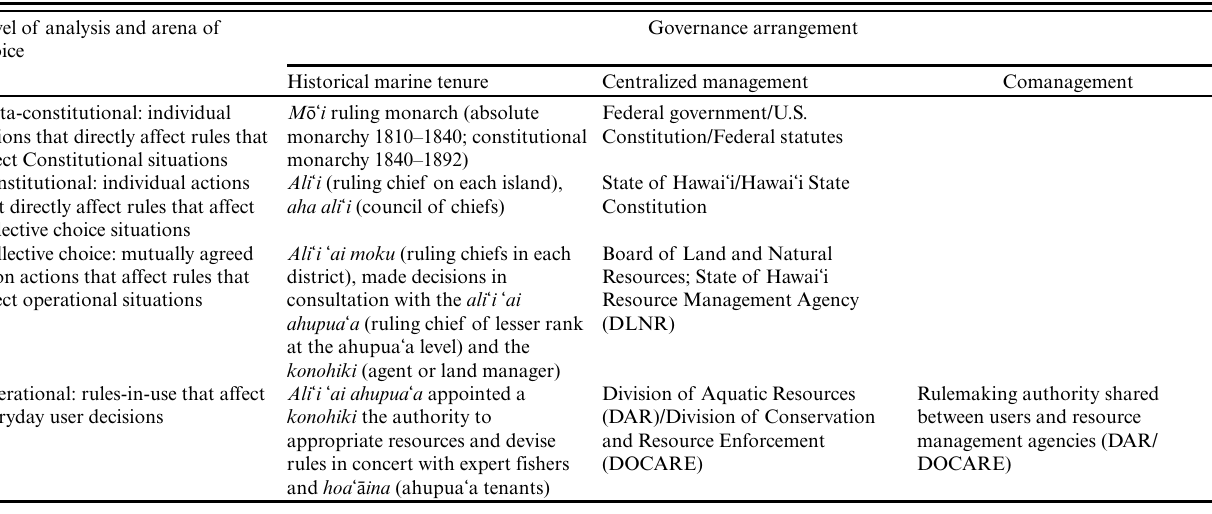
Table 4. Nested rules hierarchy and authority for small-scale fisheries in the Hawaiian Kingdom (1810–1892), contemporary centralized management (1982–2018), and contemporary comanagement